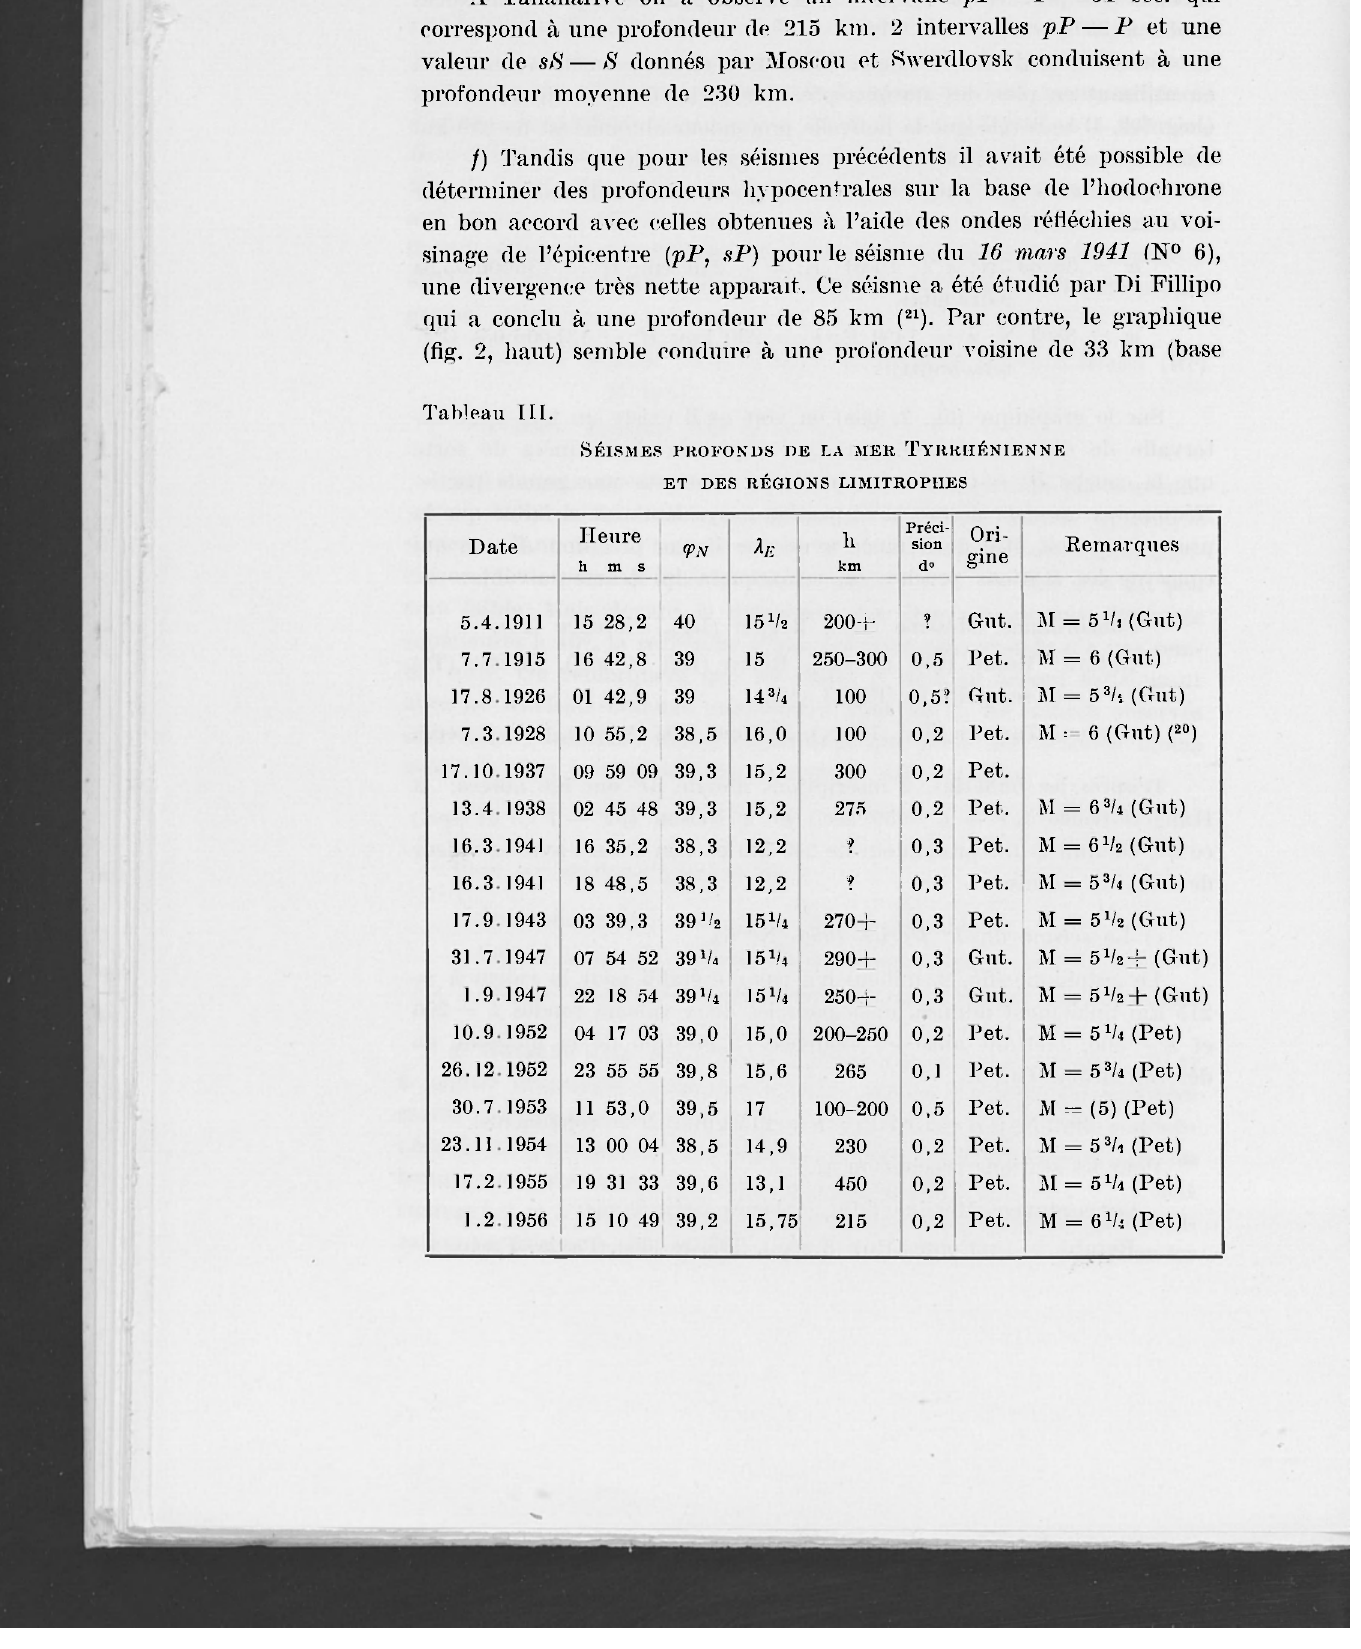
SÉISMES PROFONDS DE LA MER TYRKHÉNIENNE ET DES RÉGIONS